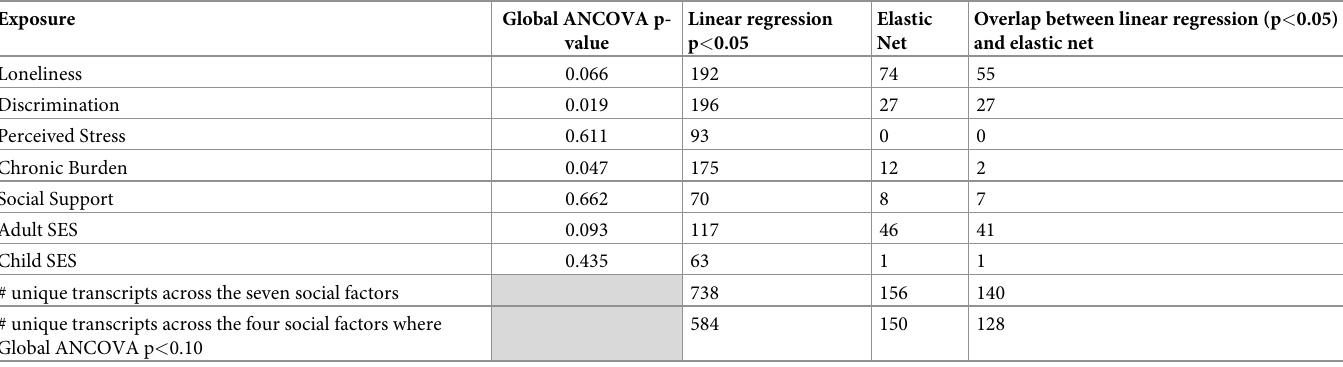
Table 3. Results of the association between social factors with the socially sensitive gene set as assessed via global ANCOVA, linear regression, and elastic